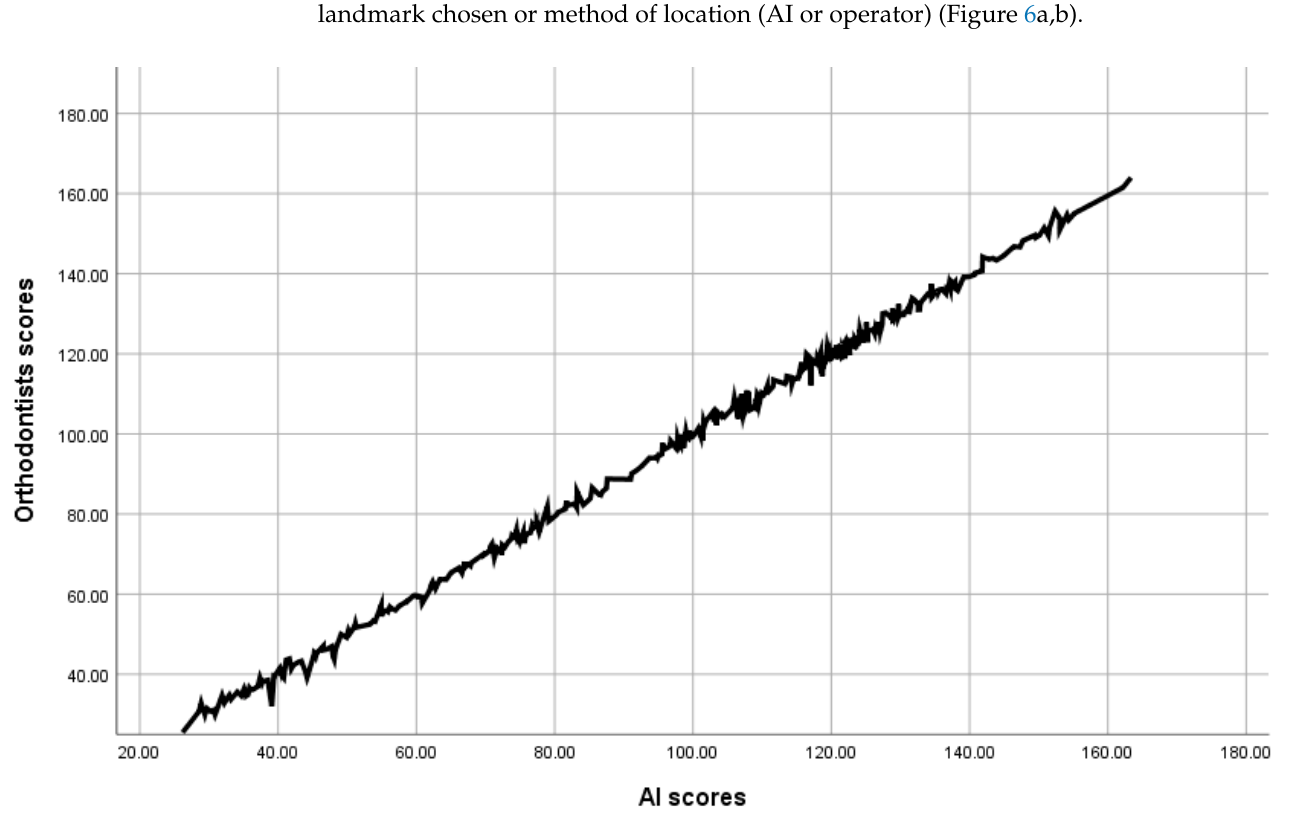
Figure 5. Correlation between general AI and observer scores.